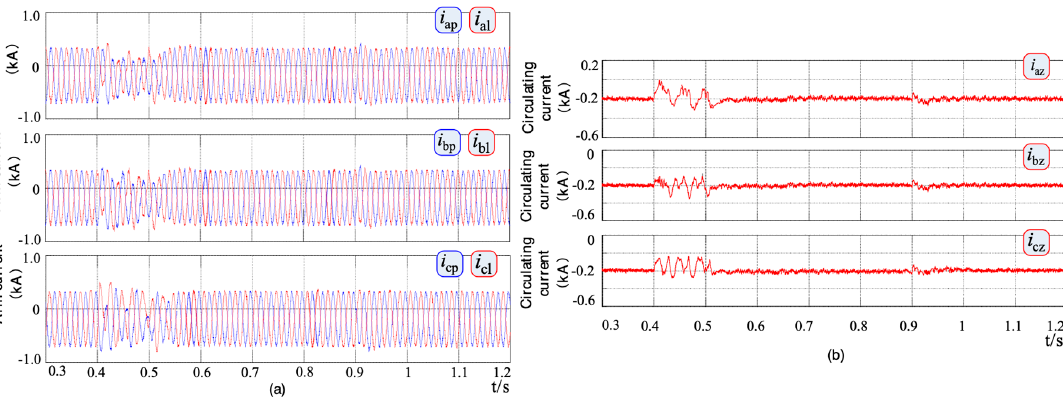
Figure A2. Simulation results of fault condition 3: ( a ) Arm current of phase j (j = a,b,c); ( b ) Circulating current of phase j (j = a,b,c).